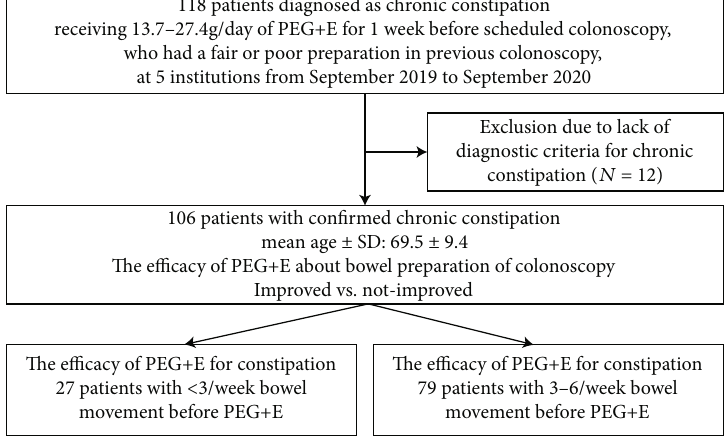
Figure 1: A fl ow diagram of the present study. PEG+E: polyethylene glycol plus electrolytes; SD: standard